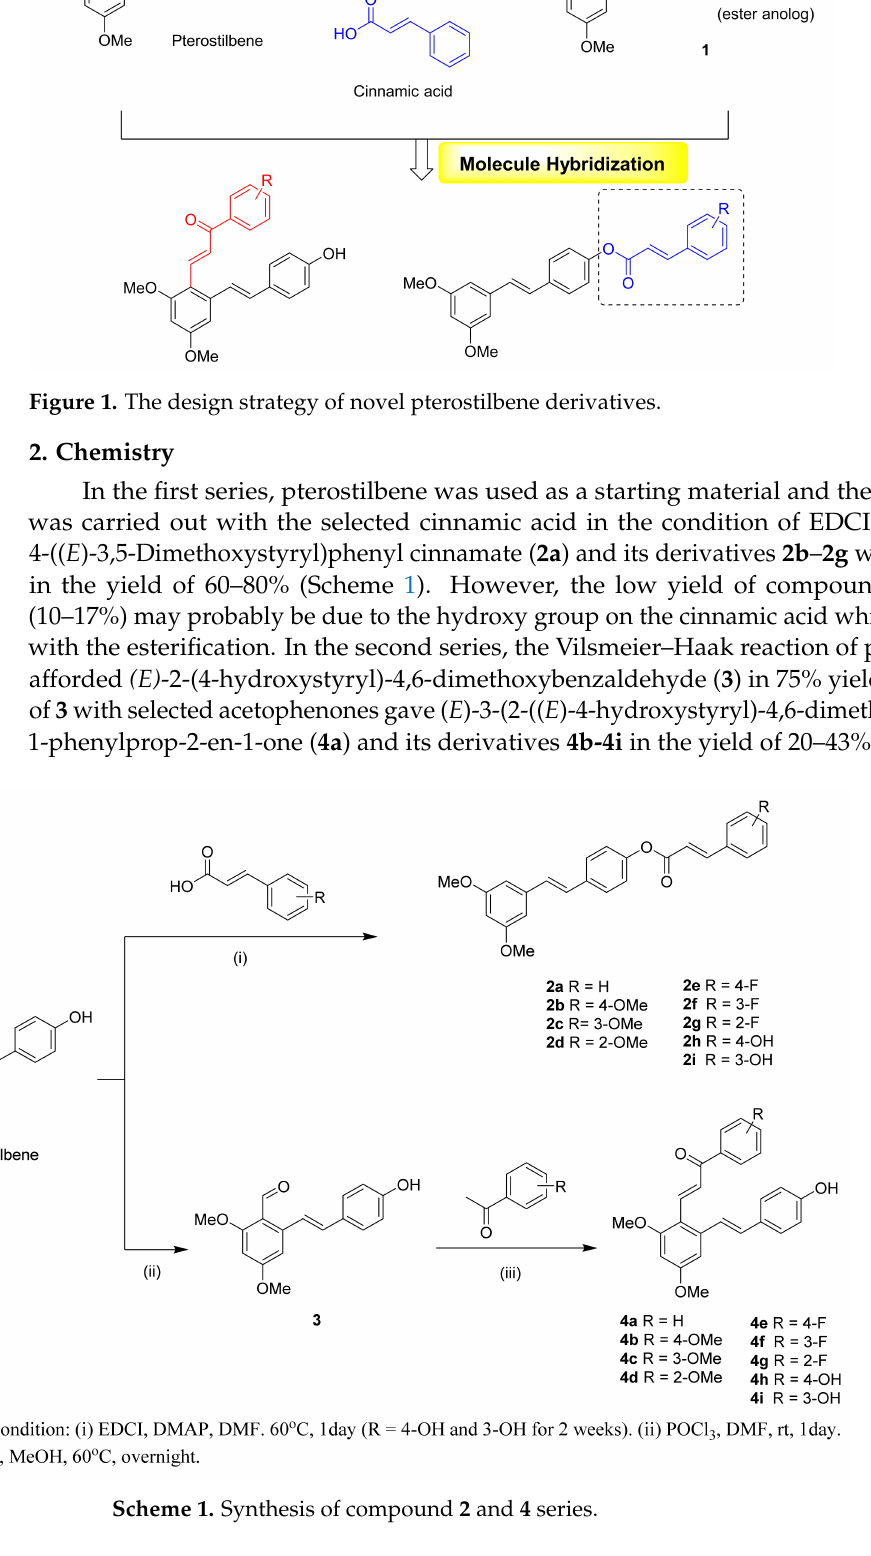
Scheme 1. Synthesis of compound 2 and 4